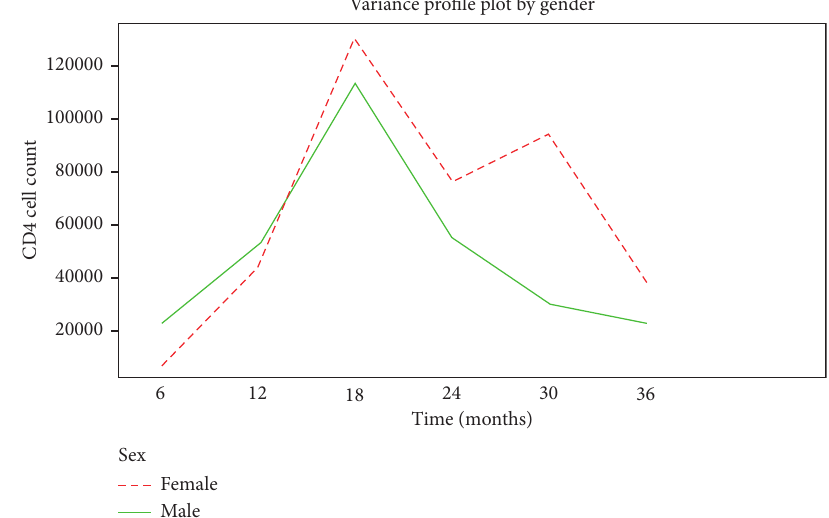
Figure 3: Variance profile plots of the longitudinal CD4 cell count by